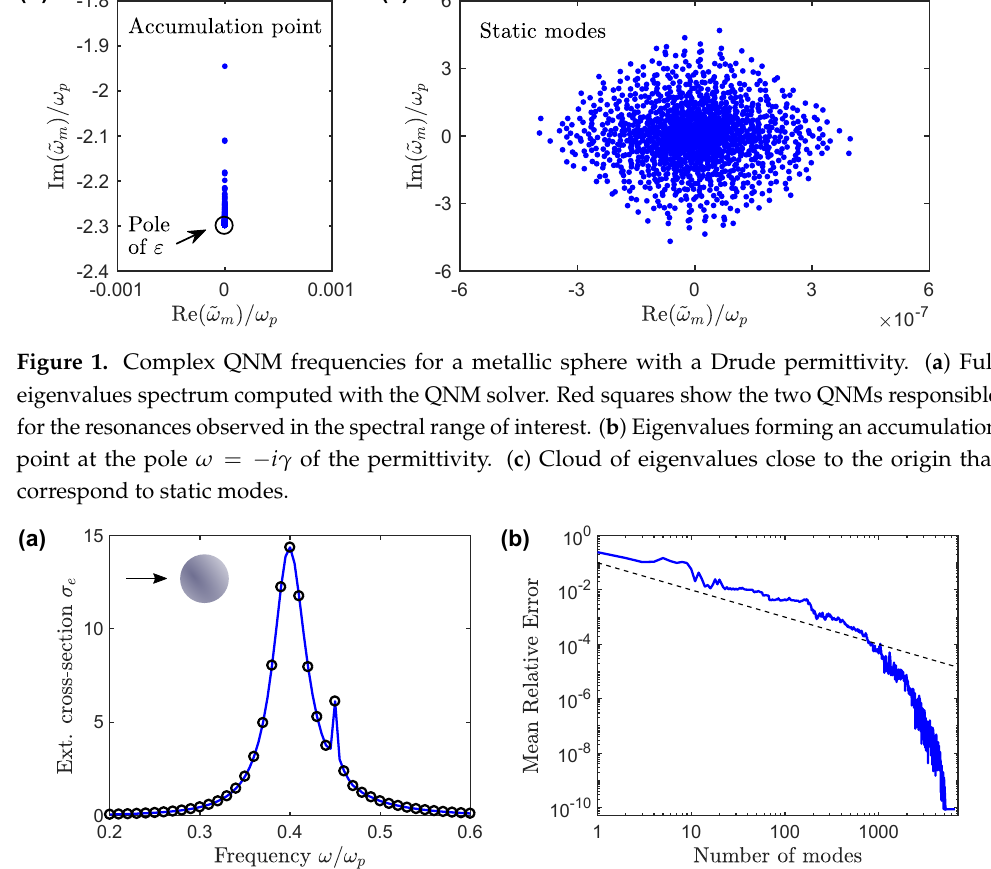
Figure 2. Convergence of the QNM expansion for a metallic sphere with a Drude permittivity. ( a ) Spectrum of the extinction cross-section normalized by the sphere apparent surface π R 2 . The results obtained with the QNM expansion (blue curve) are compared with the results of a direct FEM calculation (black circles). ( b ) Mean relative error as a function of the number of modes retained in the QNM expansion. The results of a direct FEM calculation with the same mesh are taken as a reference, and the relative error is averaged over the spectral range of ( a ). The black dashed line shows a 1/ N